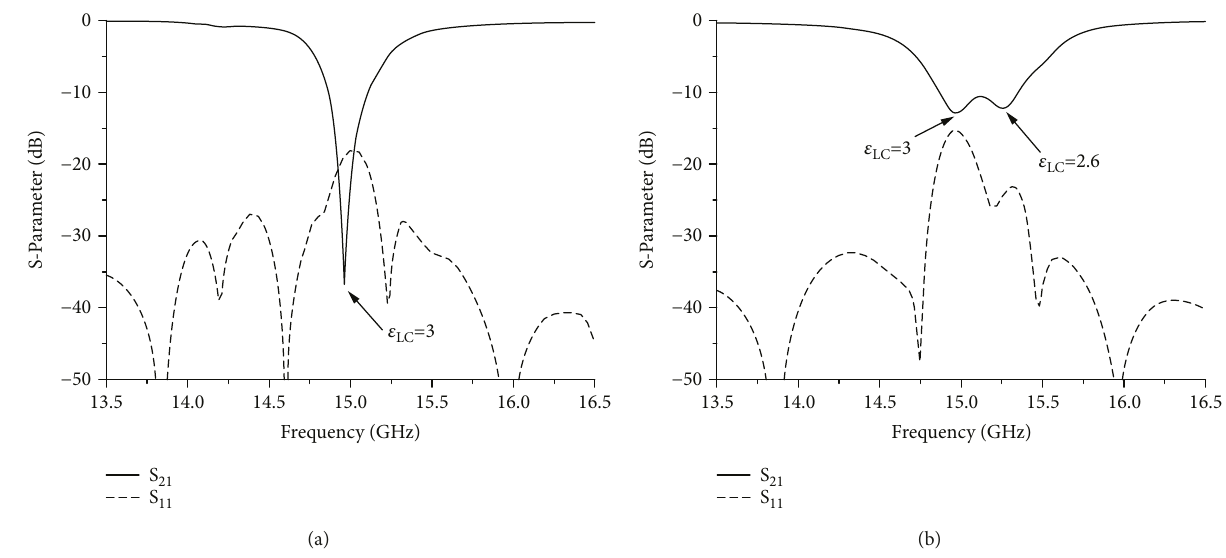
Figure 9: Simulated S-parameters of the antenna arrays: (a) Con fi guration 1; (b) Con fi guration